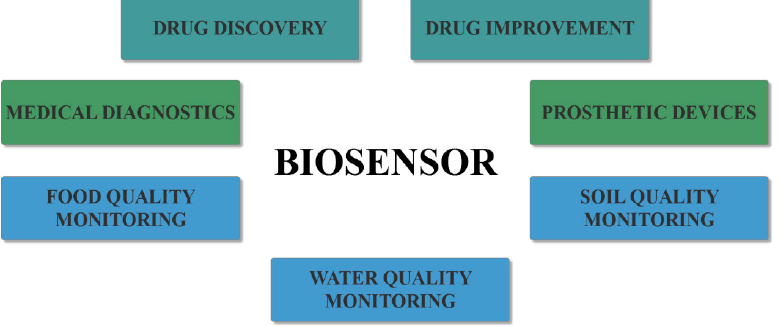
Figure 2. The main applications of biosensors.